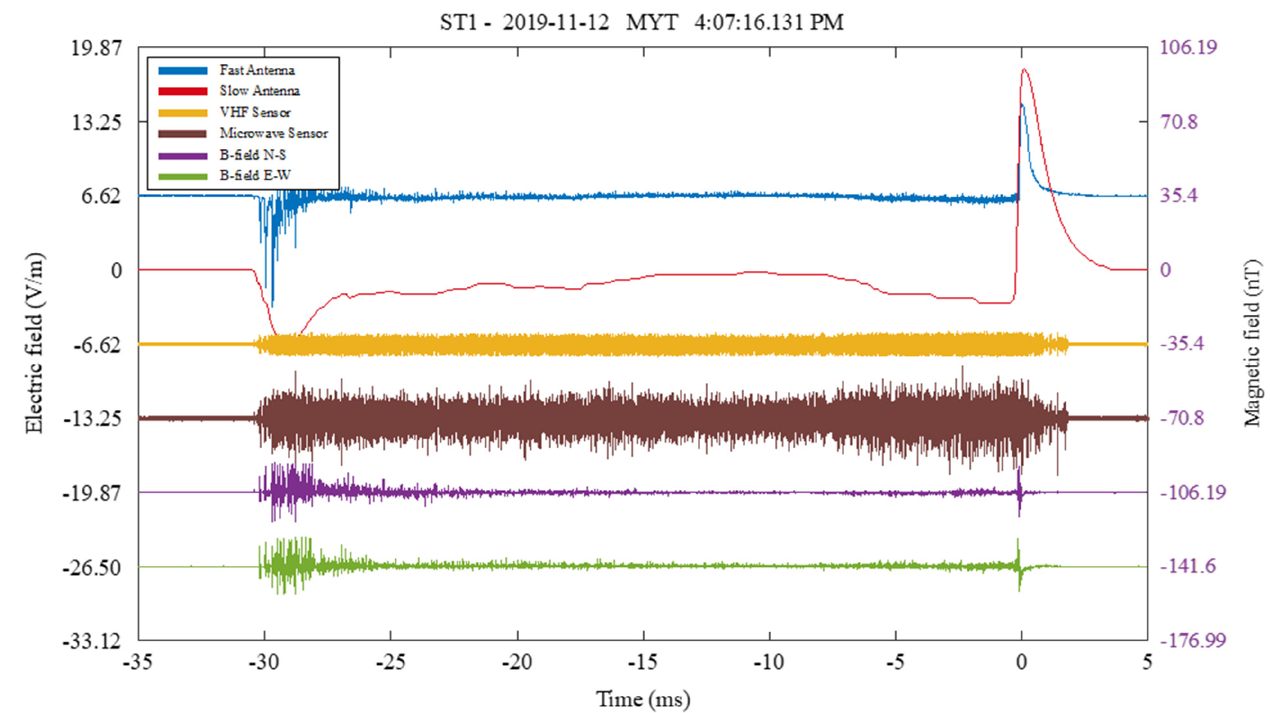
Figure 2. A negative cloud-to-ground ( − CG) flash within reversal distance captured by wideband fast (blue) and slow (red) antenna systems accompanied by VHF (gold) and microwave (brown) radiations, and magnetic field North-South (purple) and East-West (green) in ST1 Malacca at 4:07:16:131 PM MYT on 12 November 2019. (CG-4: Atmospheric electricity sign convention) [Sampling rate: 2.5 GS/s for Microwave, 250 MS/s for FA, SA, and VHF, and 2.5 MS/s for B-field].